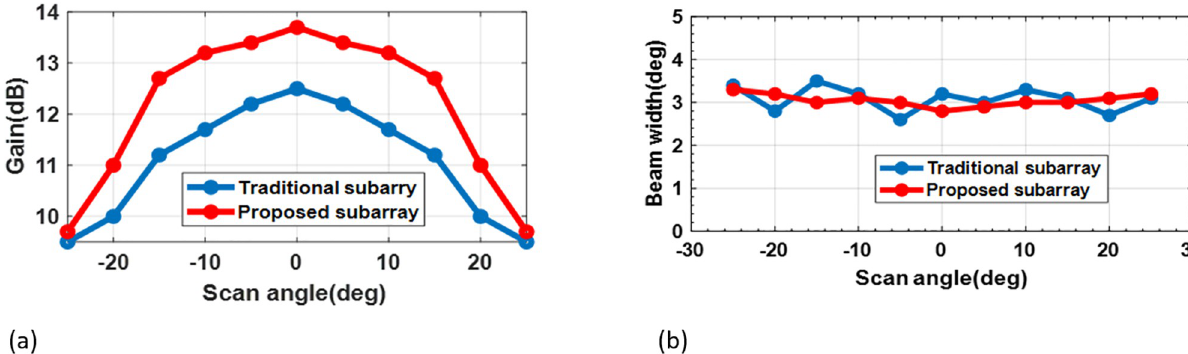
Fig 6. (a) Compare HPBW of the proposed subarray architecture ( N according to the scan angle for the proposed subarray architecture ( N psh = 23) with the traditional subarray ( N psh = 7).